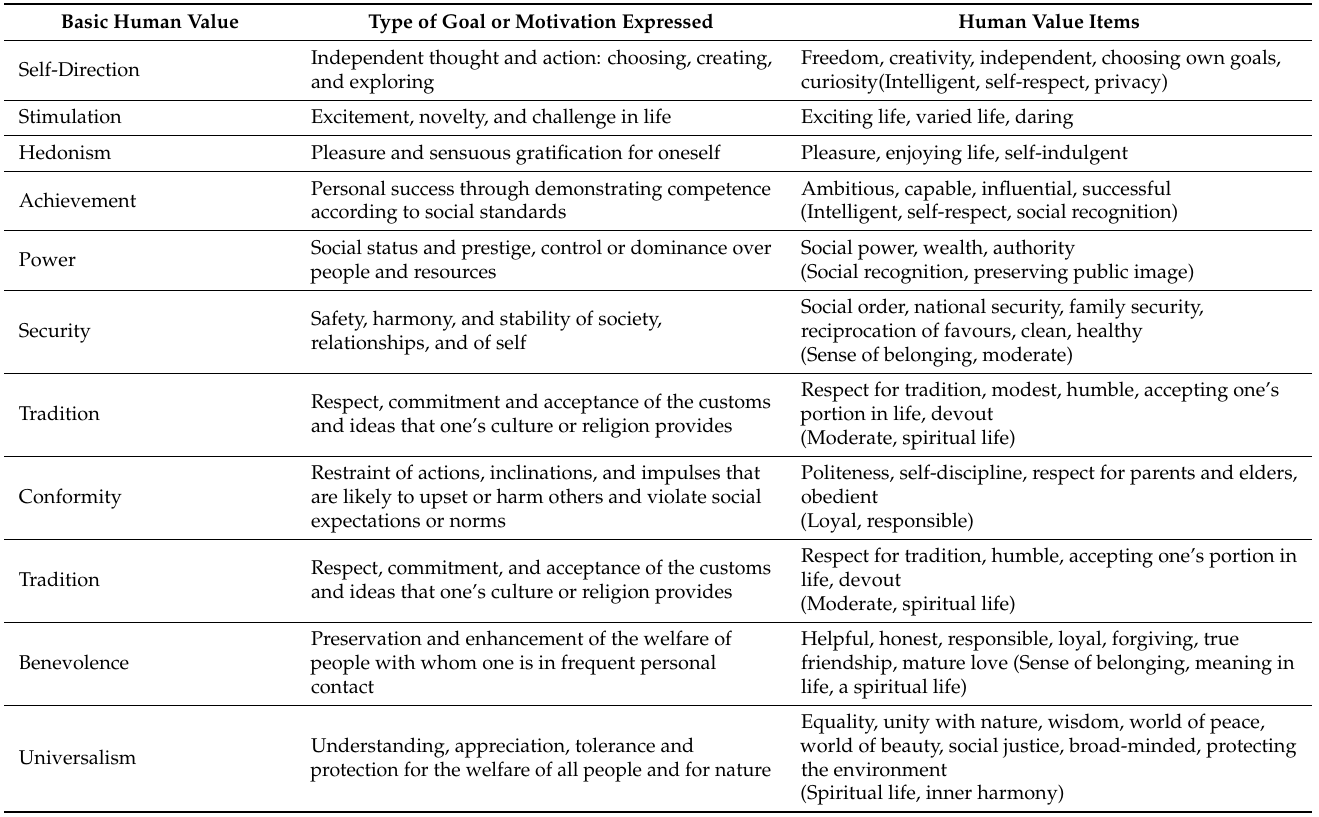
Table 1. Human value items and definition of the type of motivation expressed in Schwartz (2012) theory of basic values. Basic Human